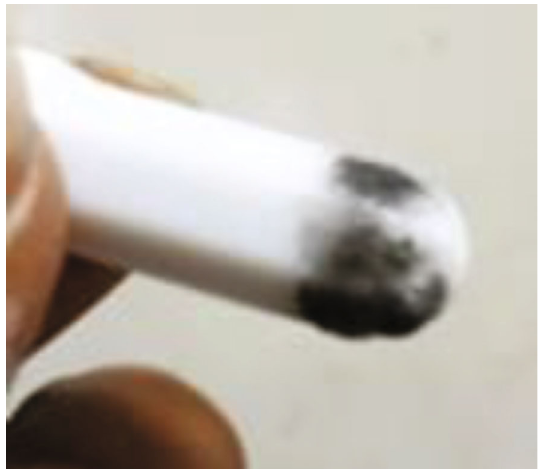
Figure 1: Magnetic beads with adsorbed impurities while puri fi cation of kaolin